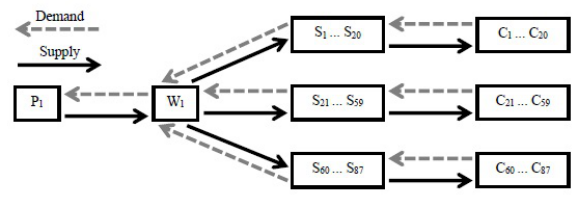
Figure 1: Model of the real food supply chain.